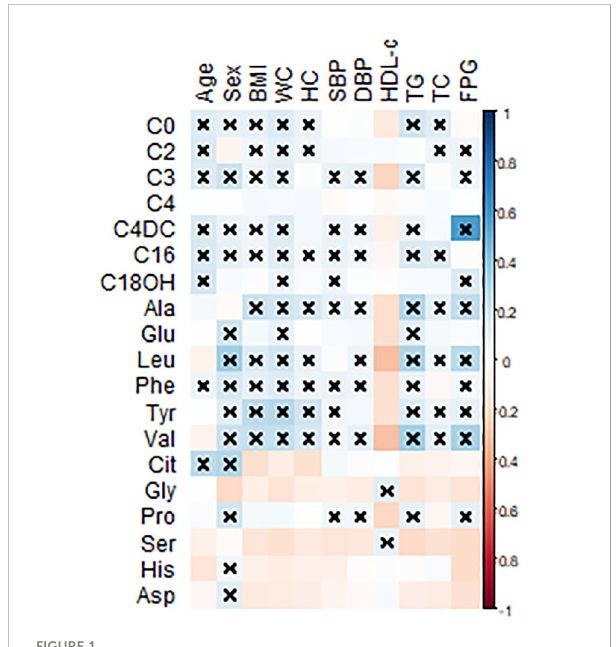
FIGURE 1 Pearson ’ s correlation coef fi cients were calculated for the 12 amino acids and 7 acylcarnitines with metabolic-related variables. BMI, body mass index; WC, waist circumference; HC, hip circumference, FPG, fasting plasma glucose; SBP, systolic blood pressure; DBP, diastolic blood pressure; TC, total cholesterol; TG, triglyceride; HDL- c, high-density lipoprotein-cholesterol; Leu, leucine; Val, valine; Tyr, tyrosine; Phe, phenylalanine; Glu, glutamic acid; Ala, alanine; Gly, glycine; Cit, citrulline, His, histidine; Asn, asparagine; Pro, proline. All statistically signi fi cant associations were marked with a multiplication sign. Statistical differences are shown as × P <